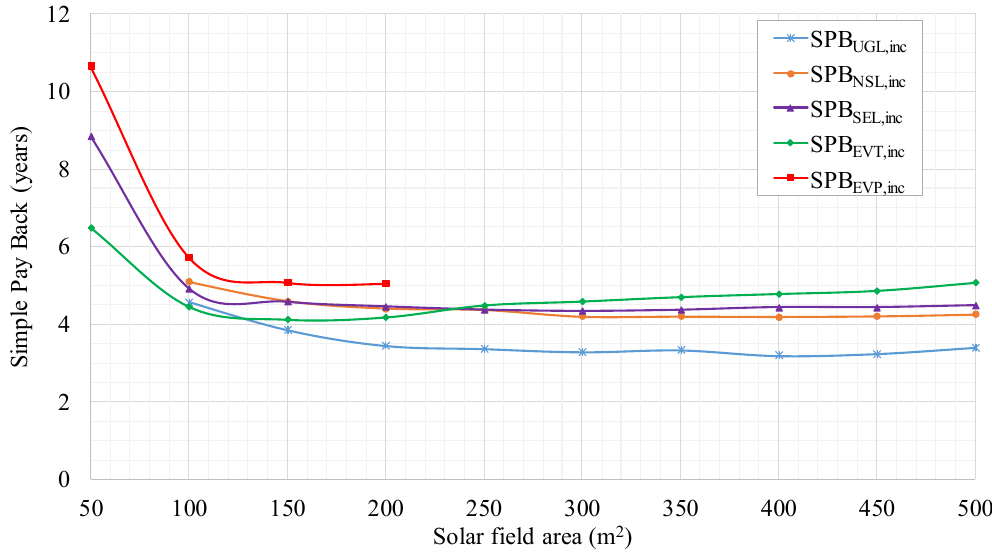
Figure 14. Simple Pay Back period with incentive vs. solar field area, parametric analysis.